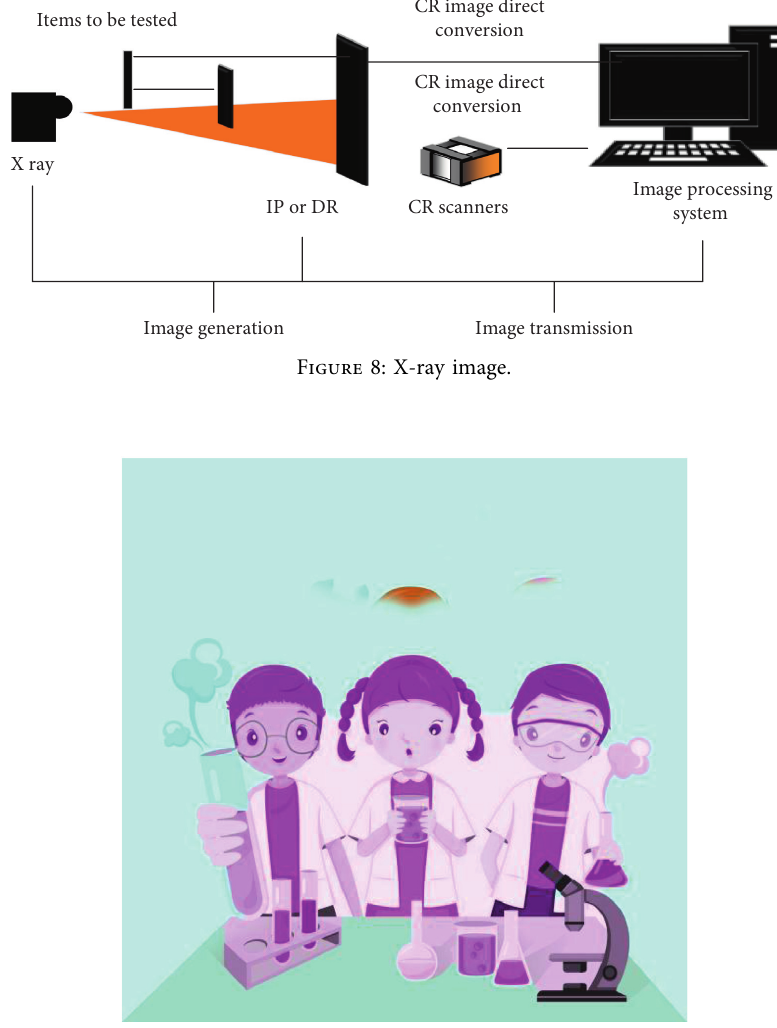
Figure 9: Reference relative experimental